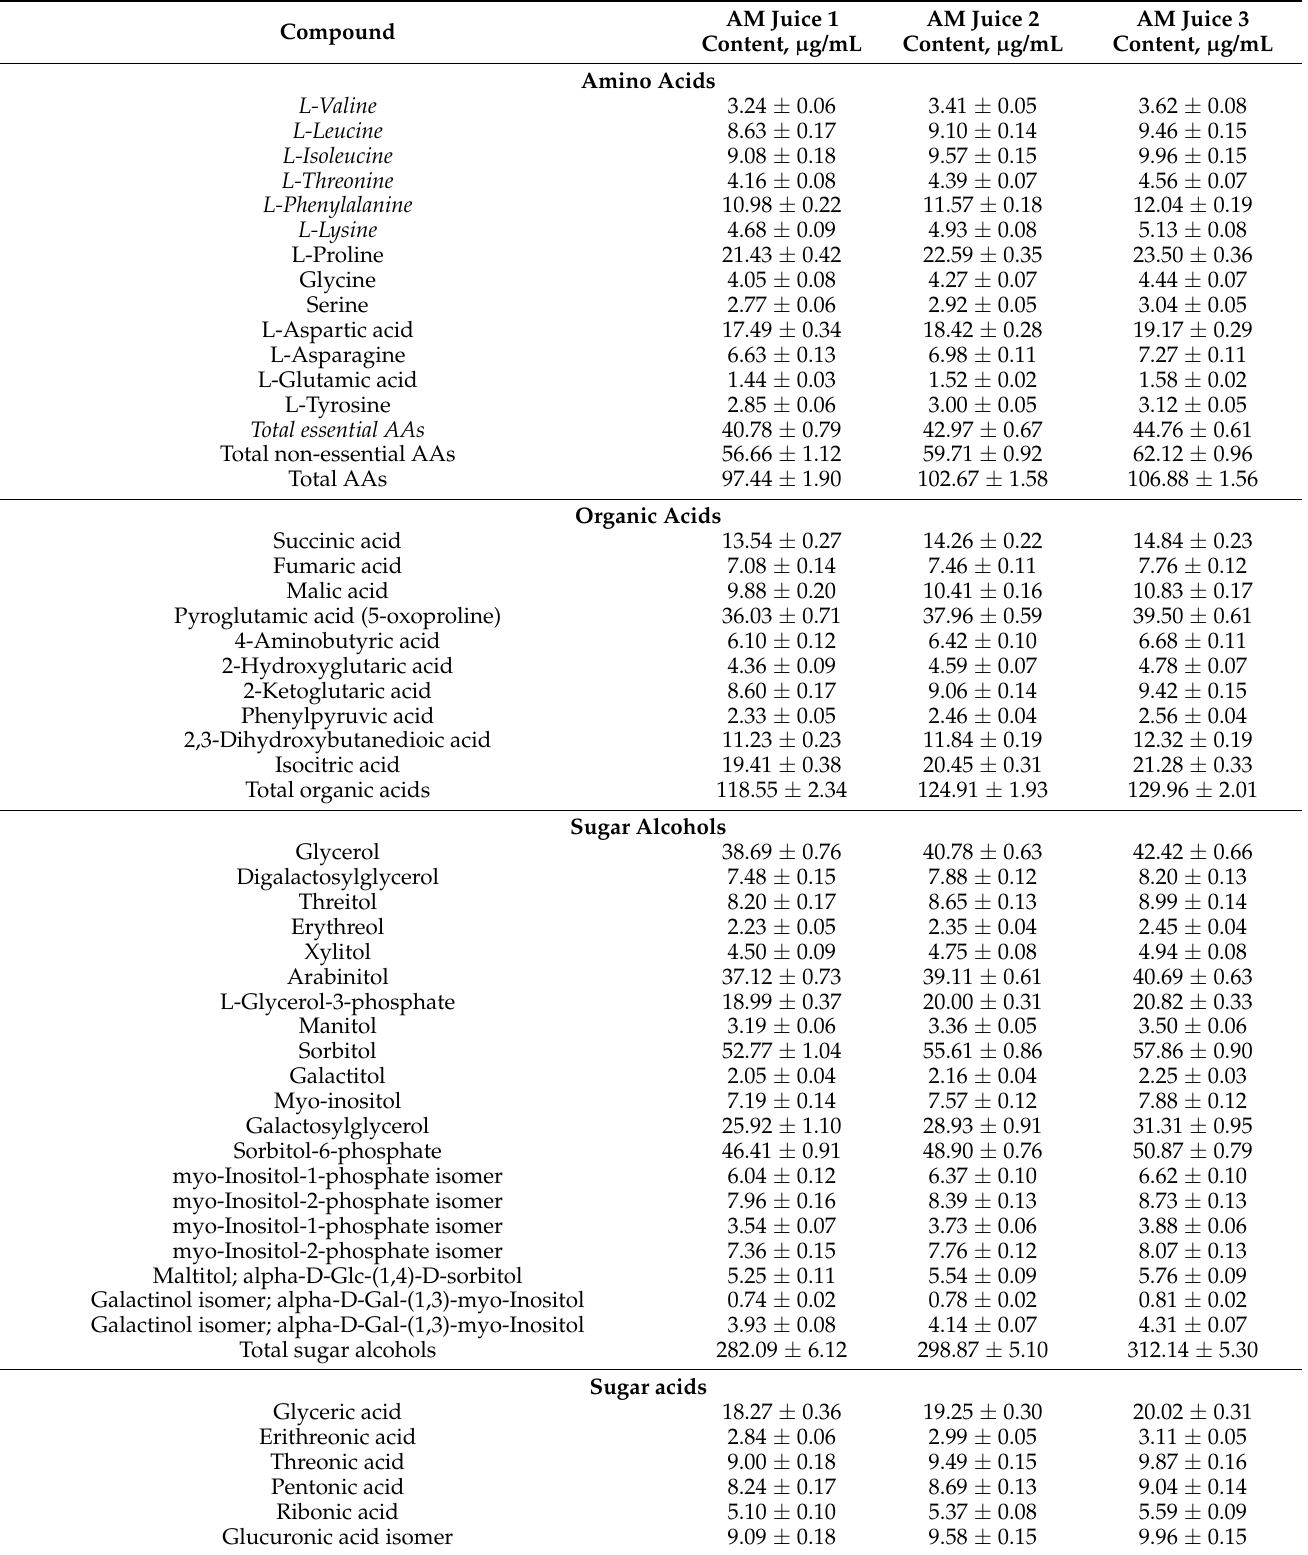
Table 1. Polar phytochemicals identified in fraction A of Aronia melanocarpa L. fruit juice using GC-MS. The concentration is given in µ g/mL. Results are presented as mean ± standard